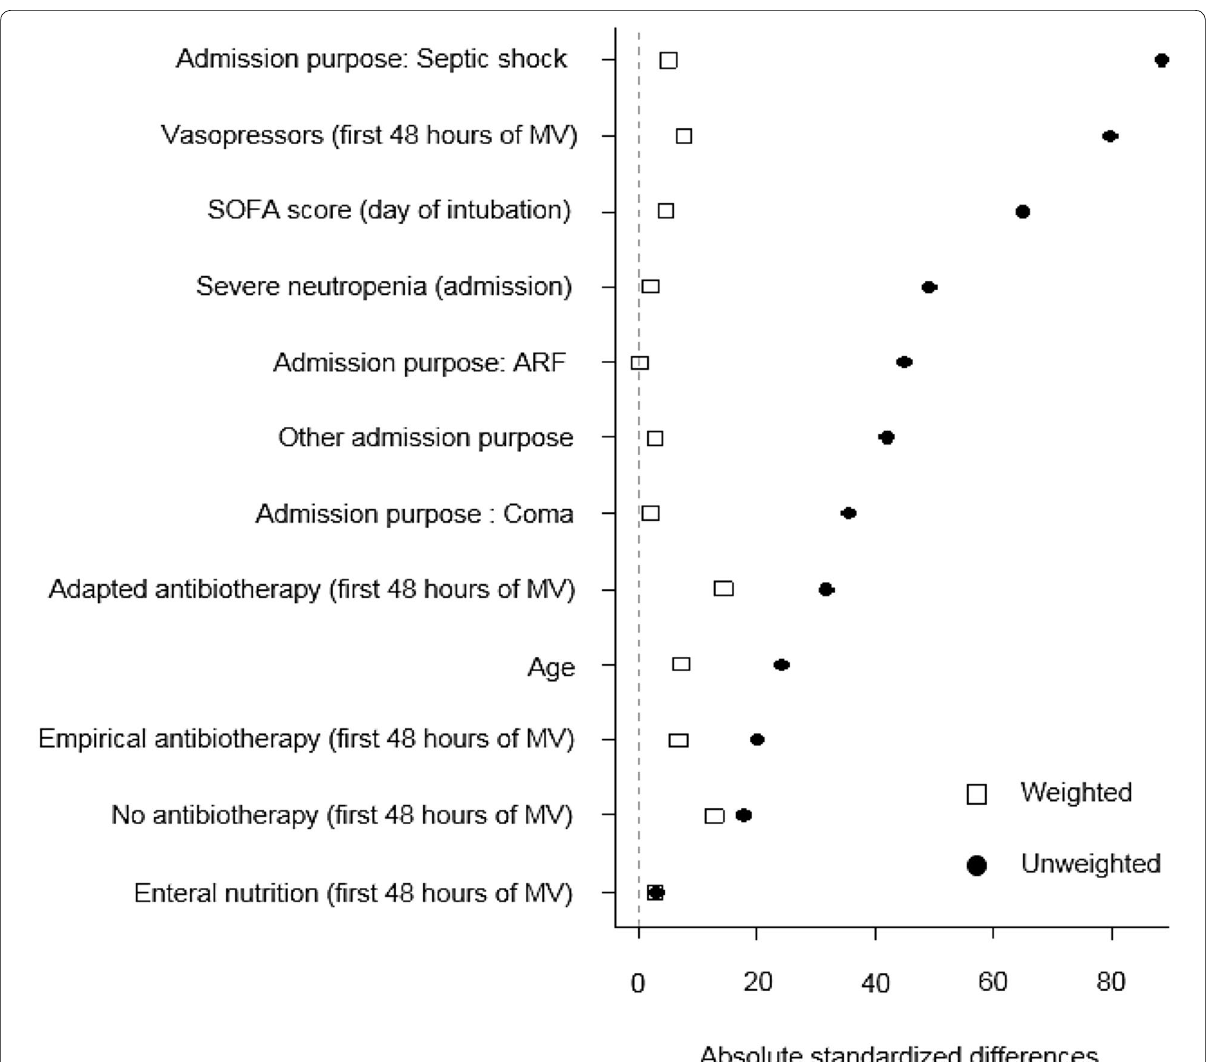
Fig. 1 Covariate imbalance (assessed by standardized mean differences) between the two groups of patients receiving and not receiving early HC in the unweighted (original) and weighted